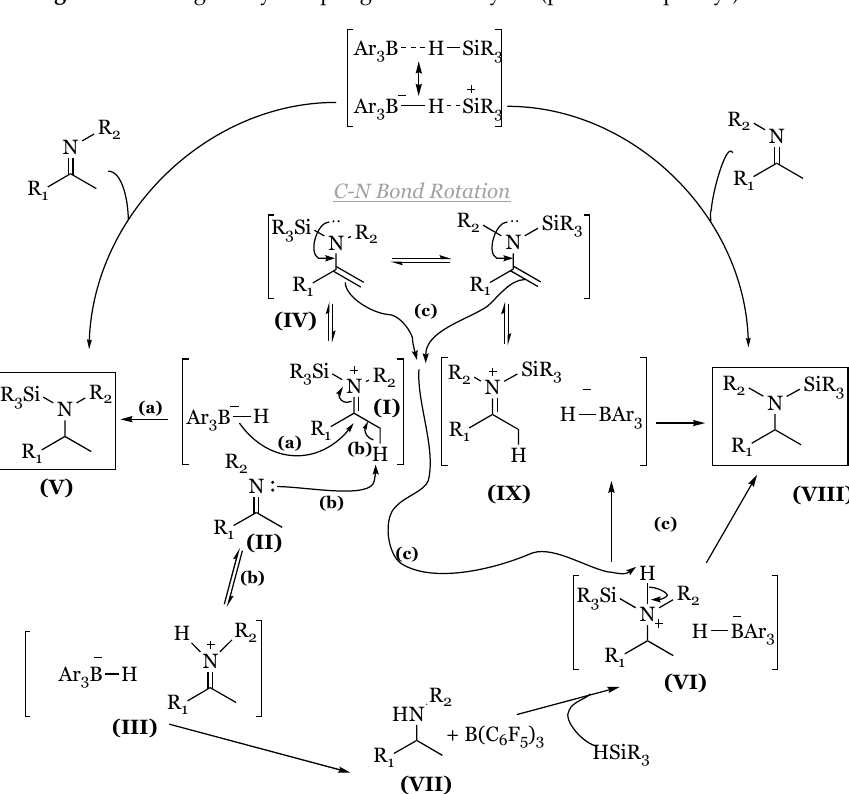
Figure 44. Refined mechanism of reducing N -substituted imines bearing an α -hydrogen atom to N -silylated amines: ( a ) hydridoborate reduction of N -silylated iminium ion; ( b ) loss of proton from N -silylated iminium ion to give iminium ion (III) and enamine (IV); ( c ) deprotonation of N -silylated ammonium ion to give silyl iminium ion (IX) and N -silylated amine (VIII).